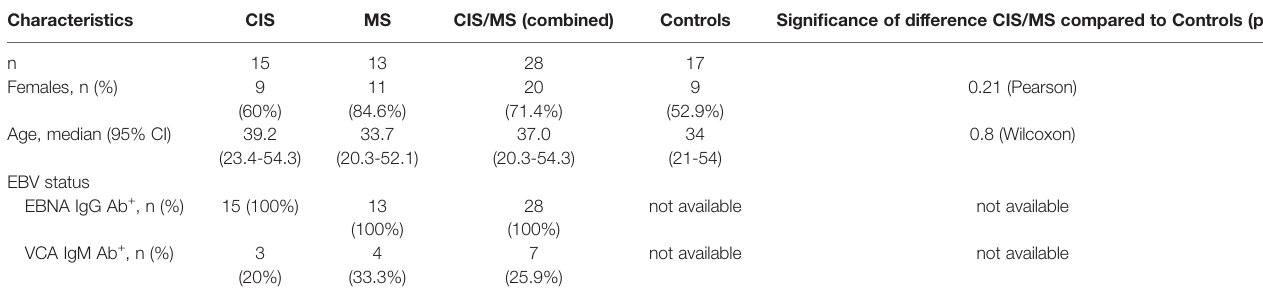
TABLE 1 | Study Participant